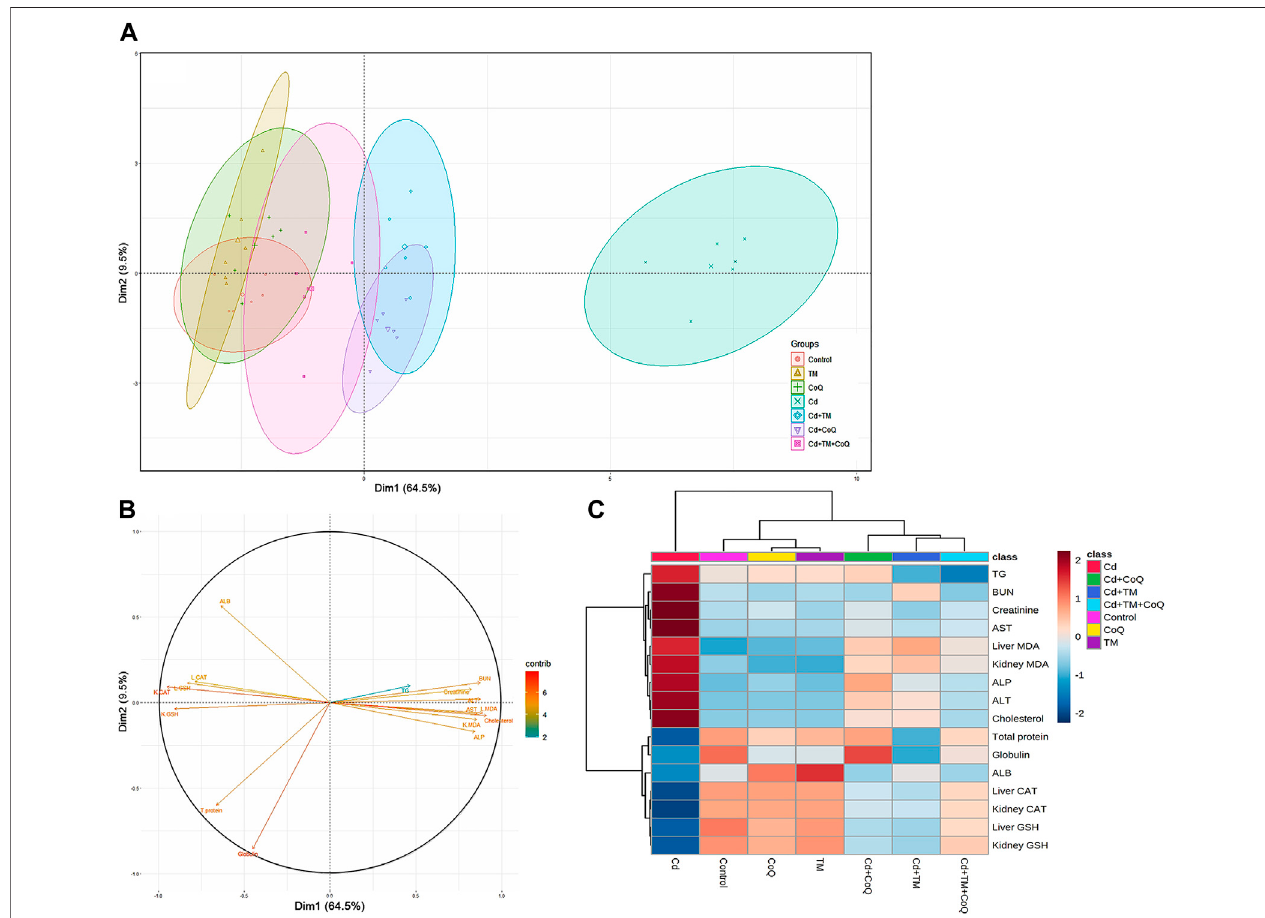
FIGURE 7 | Principal components analysis (PCA) of TM and CoQ against Cd-induced hepatorenal toxicity. (A) PCA for discriminating the seven experimental groups (Control, TM, CoQ,Cd, Cd+TM, Cd+CoQ,and Cd +TM+CoQ). Percentage valuesindicated ontheaxes represent thecontributionrateofDim1and Dim2to thetotalamountofvariations. (B) Thedegreeofcontributionofvariousvariables.Thecontributionstrengthisindicatedbyacoloredscalerangingfromthehighest(red)to lowest(blue).Cd,cadmium; CoQ,coenzymeQ10;Dim,dimension;TM, Tamarindusindica . (C) Hierarchicalclusteringheatmapprovidesintuitivevisualizationofall data sets. Each colored cell on the map corresponds to concentration values, with variable averages in rows and different treatments in columns. The gradient scale ranges from dark red (highest value) to blue (lowest value).